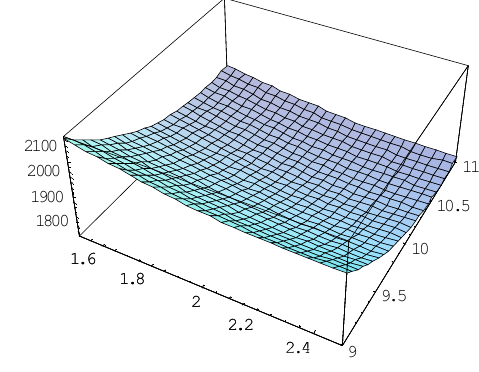
* and T w.r.t TC Fig. 4. Convexity of t 4